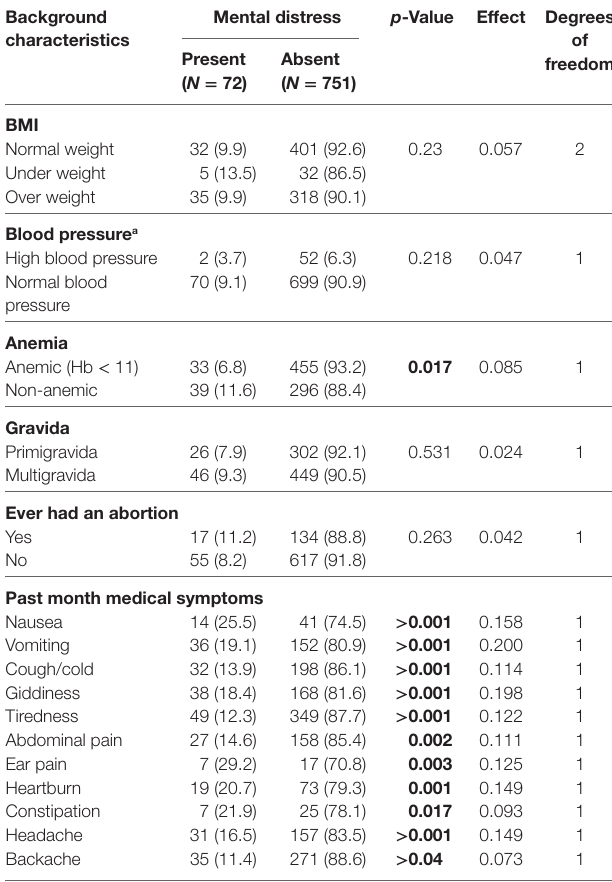
TaBle 1 | Sociodemographic factors and mental distress in pregnancy ( N = 823).